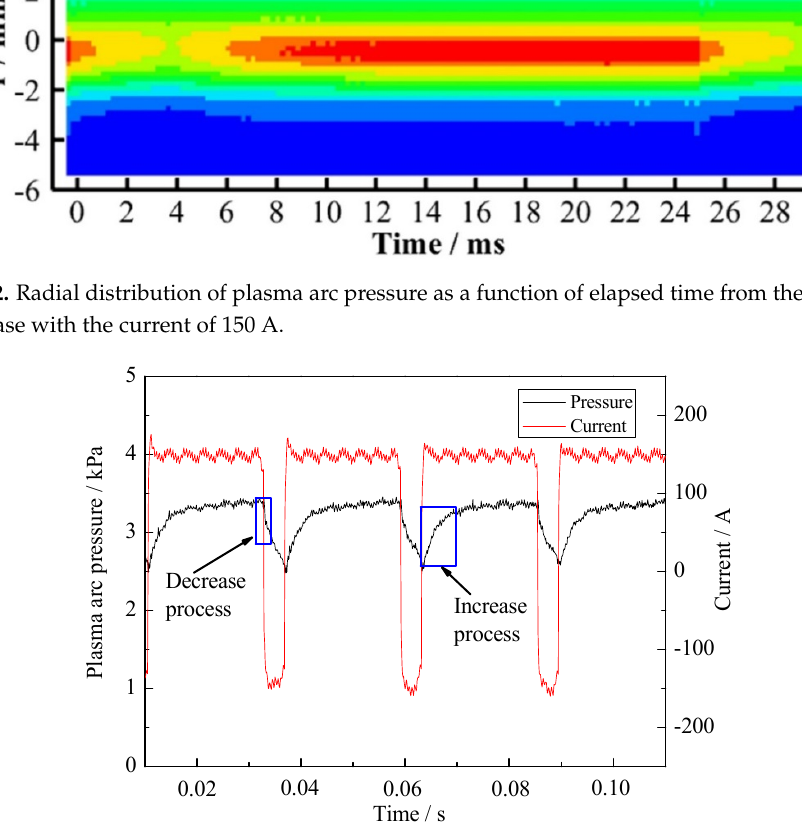
Figure 13. The evolution of plasma arc pressure and current in the center region of arc with 150 A in EN and EP phase.